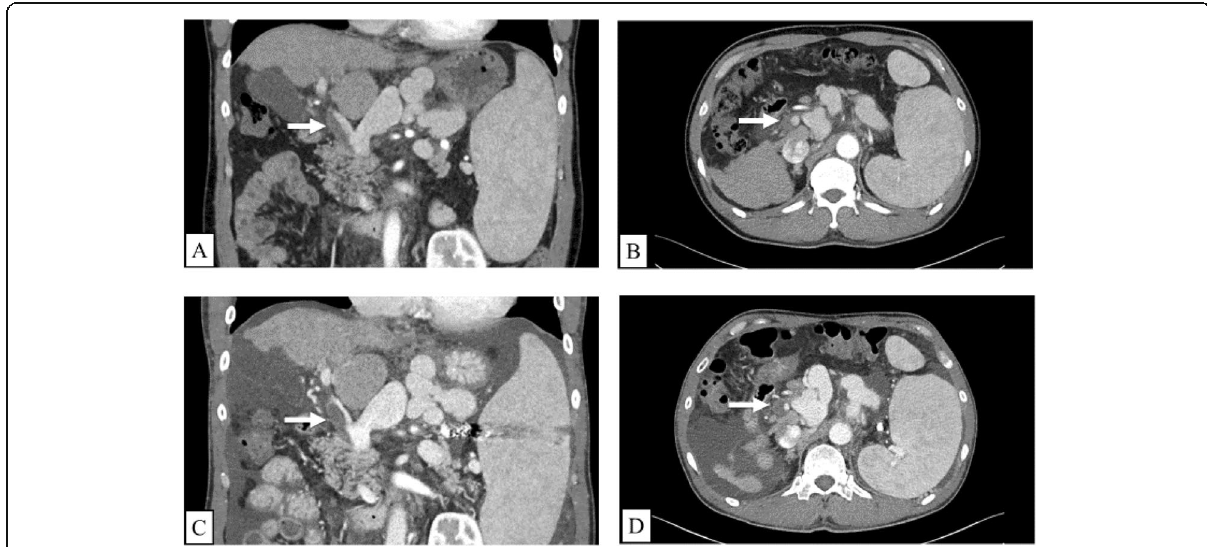
Fig. 1 The CT findings of the pre-transplant PVT before and after the administration of AT III. The Yerdel classification of the pre-transplant PVT was grade II before the administration AT III ( a and b ). However, the pre-transplant PVT was progressed regardless of the administration AT III ( c and d )